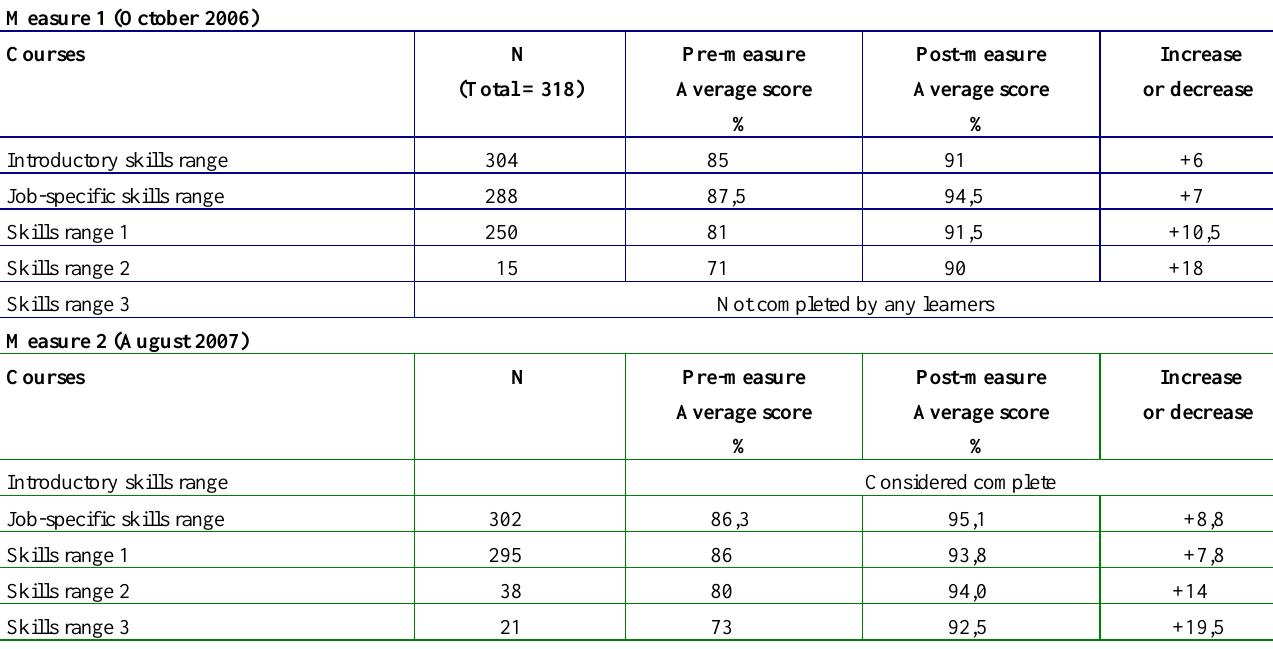
Table 5 reflects the learning system pre-post ID model implementation job-specific knowledge